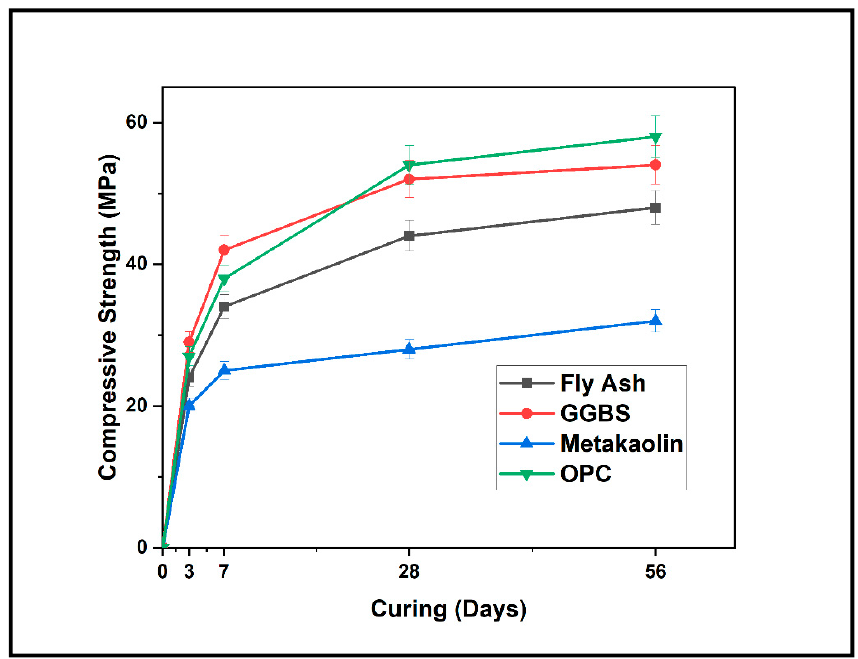
Figure 7. Compressive strength of mortar at 3rd, 7th, 28th and 56th